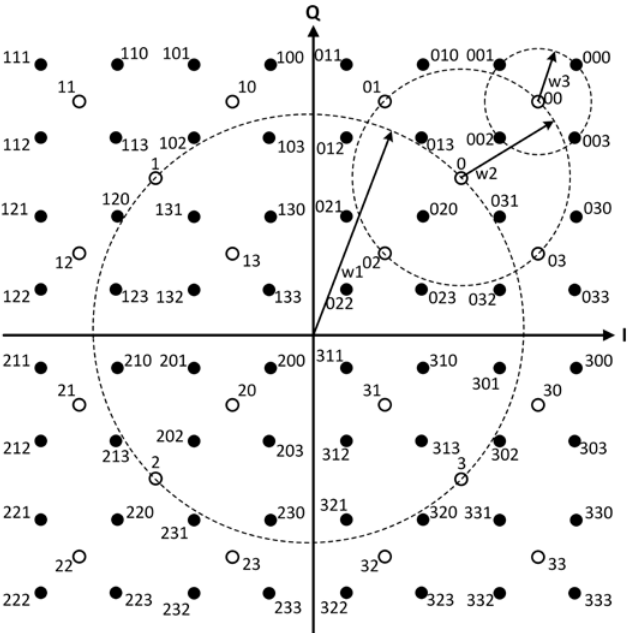
Figure 1. Construction of a 64-QAM constellation with three QPSK constellations.